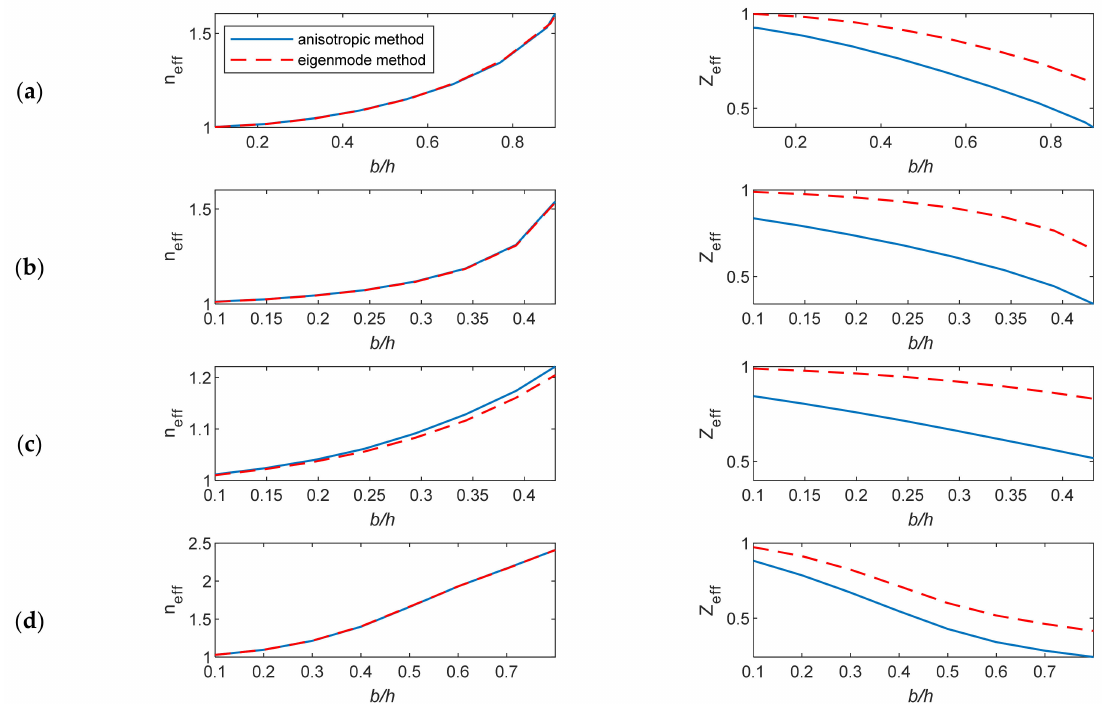
Figure 5. The extracted n eff and Z eff versus the ratio b/h for the unit cells A , B , C and D . ( a ) Unit cell A , ( b ) unit cell B , ( c ) unit cell C , and ( d ) unit cell D